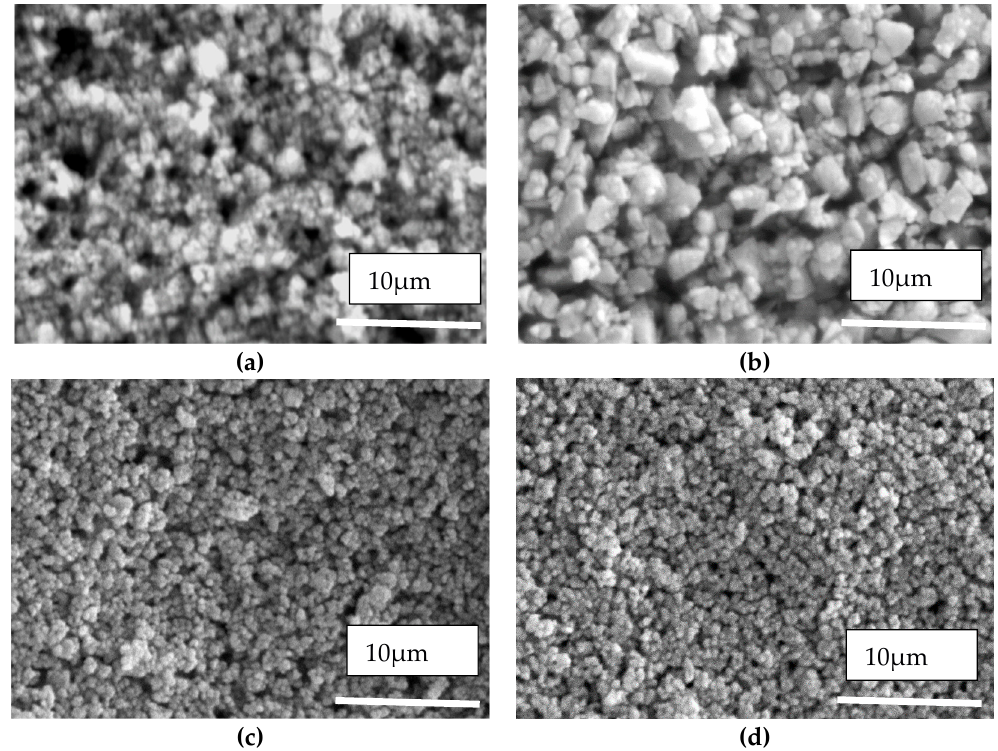
Figure 3. High magnification SEM images of the dried suspensions of ( a ) C1, ( b ) C2, ( c ) HM1, and ( d ) HM2, revealing the original powder particle shapes and sizes.